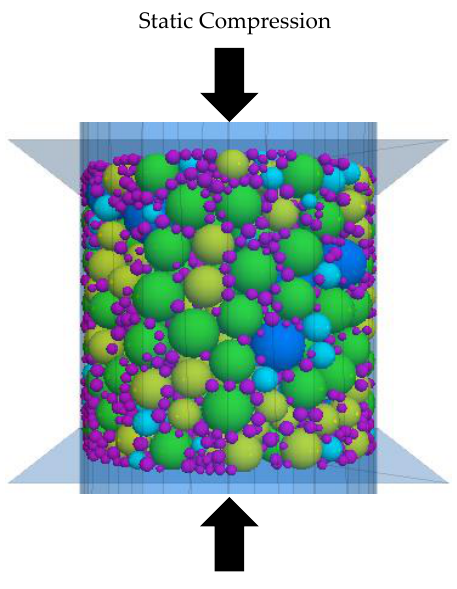
Figure 3. Virtual compression model.